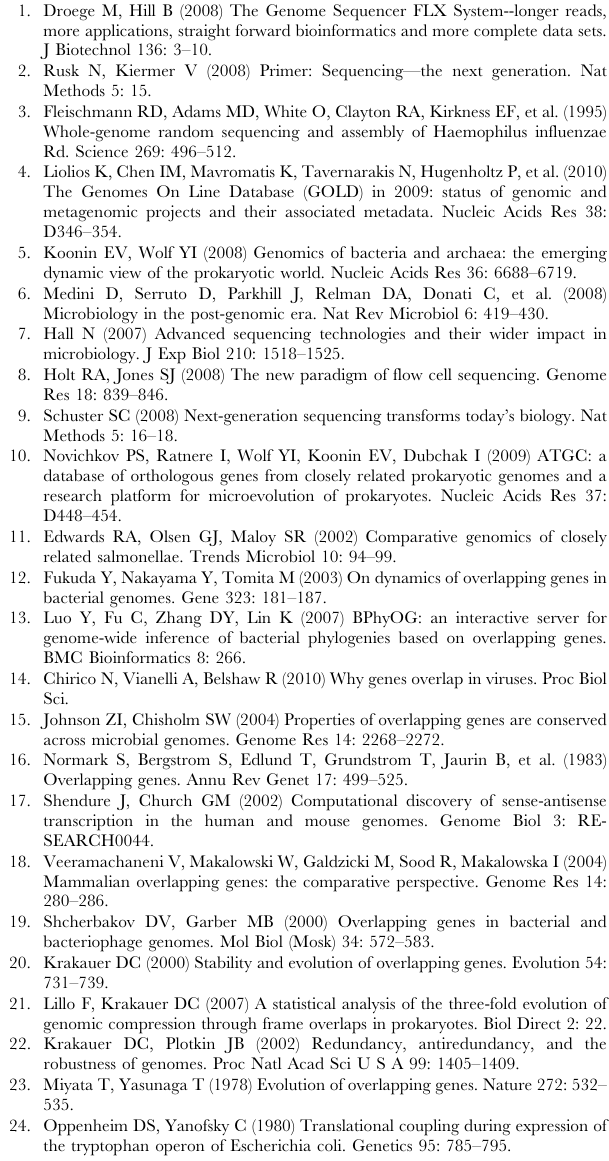
Table S1 The overall set of pan-Overlaps in Salmonella and E. coli . The first sheet in the Table S1 contains all pan- Overlaps inside operons and the second sheet in the Table S1 contains all pan-Overlaps outside